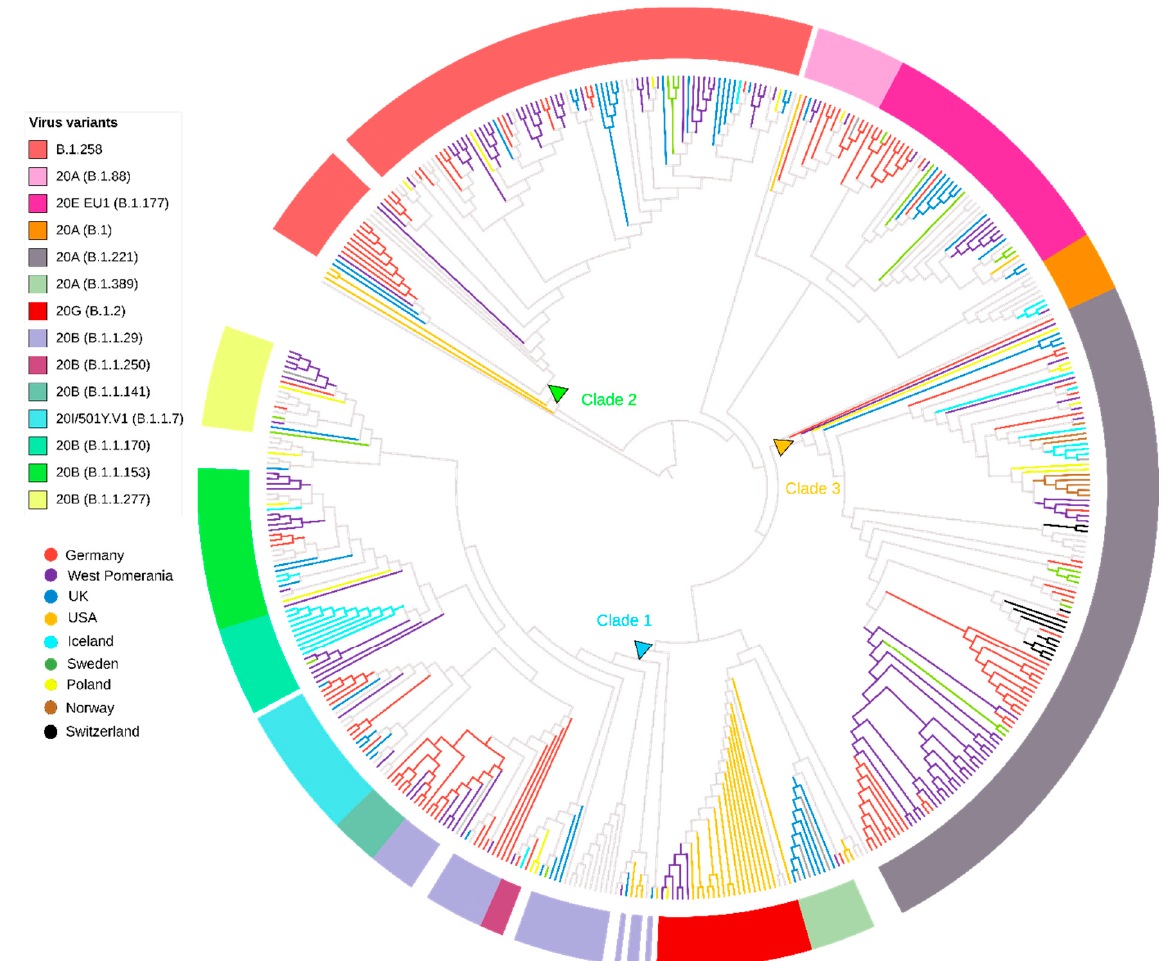
Figure 4. Phylogenetic tree of West Pomeranian SARS-CoV-2 sequences (n = 122) with an international context. Maximum likelihood tree of West Pomeranian SARS-CoV-2 sequences and a subset of BLAST sequences (n = 376) from GISAID database. Thirty countries of isolates’ origin have been identified. For eight countries that had a minimum of four (>1%) distinguished sequences, branches are colored. Multicolor rings correspond to the PANGO and Nextstrain virus classification. The blue, green, and orange triangles mark the node origins of the Clades 1–3.